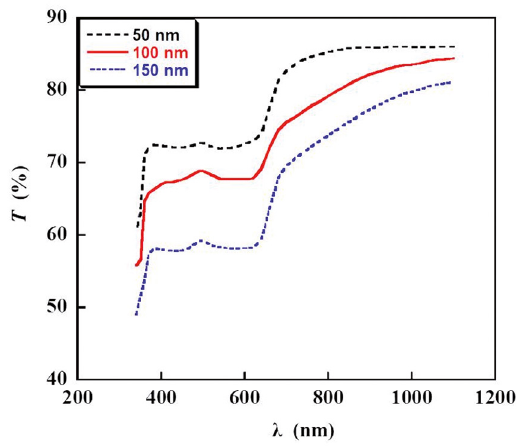
O thin films as a function 2 3